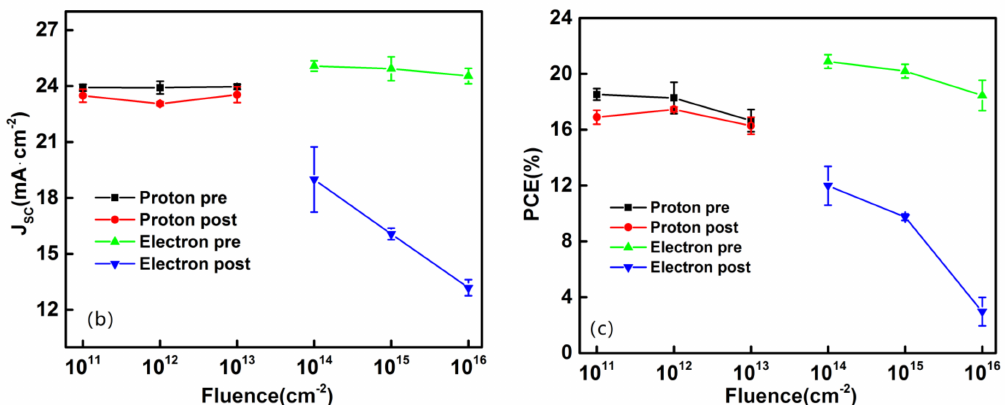
Figure 3. ( a ) Photocurrent density, ( b ) J sc and ( c ) PCE % under electron and proton irradiation with different